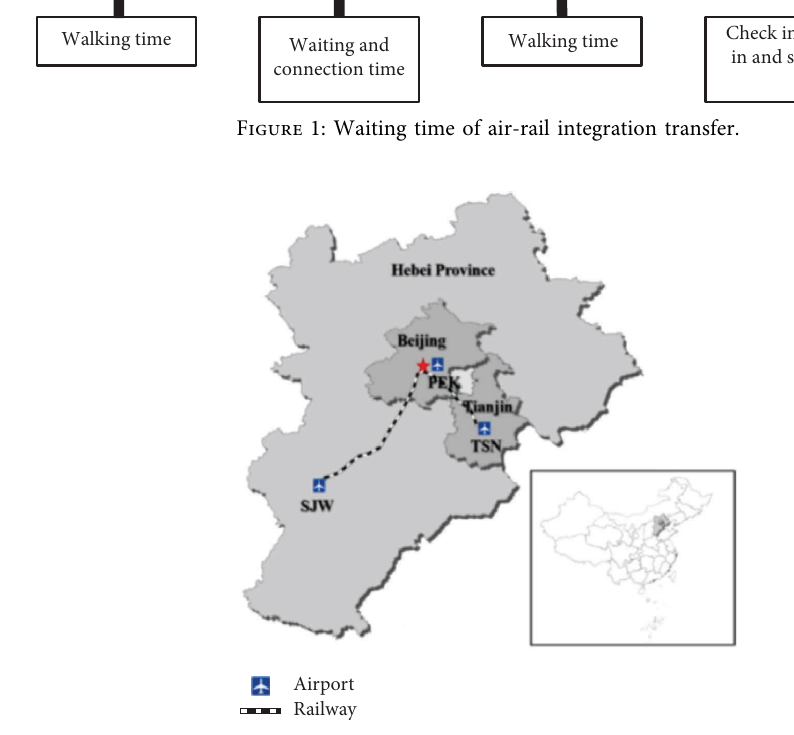
Figure 2: Te geographical information of